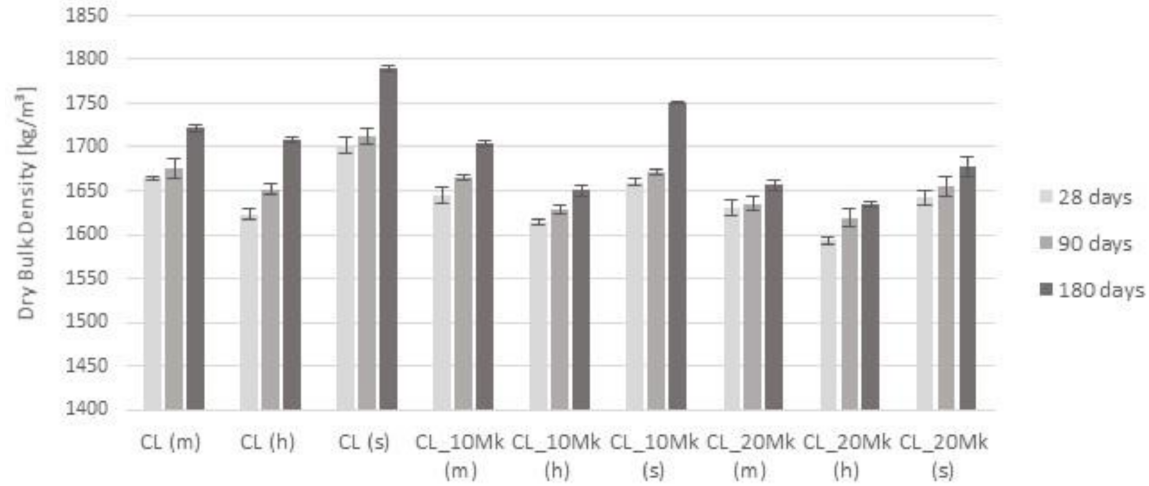
Figure 7. Dry bulk density of mortars with 0, 10 and 20% Mk replacing air lime, after 28, 90 and 180 days in maritime, humid and standard curing conditions.